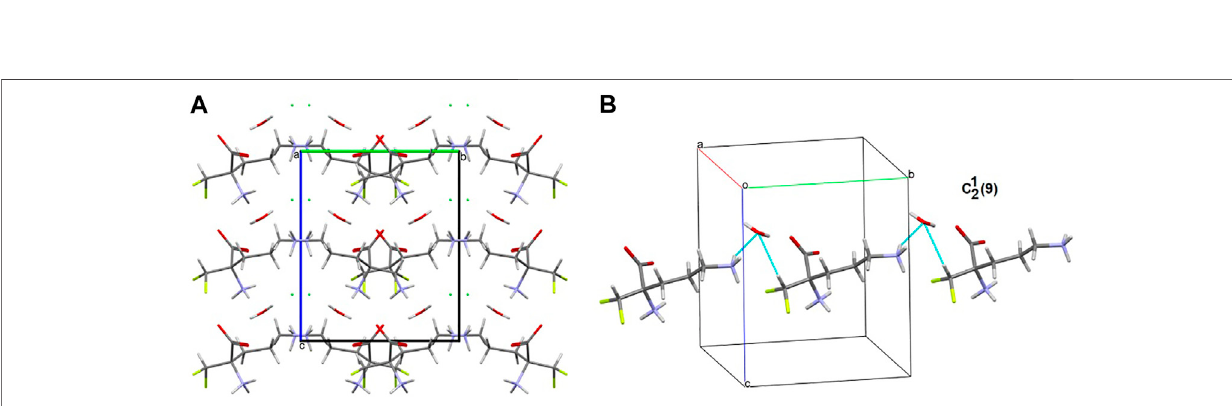
Frontiers in Chemistry |